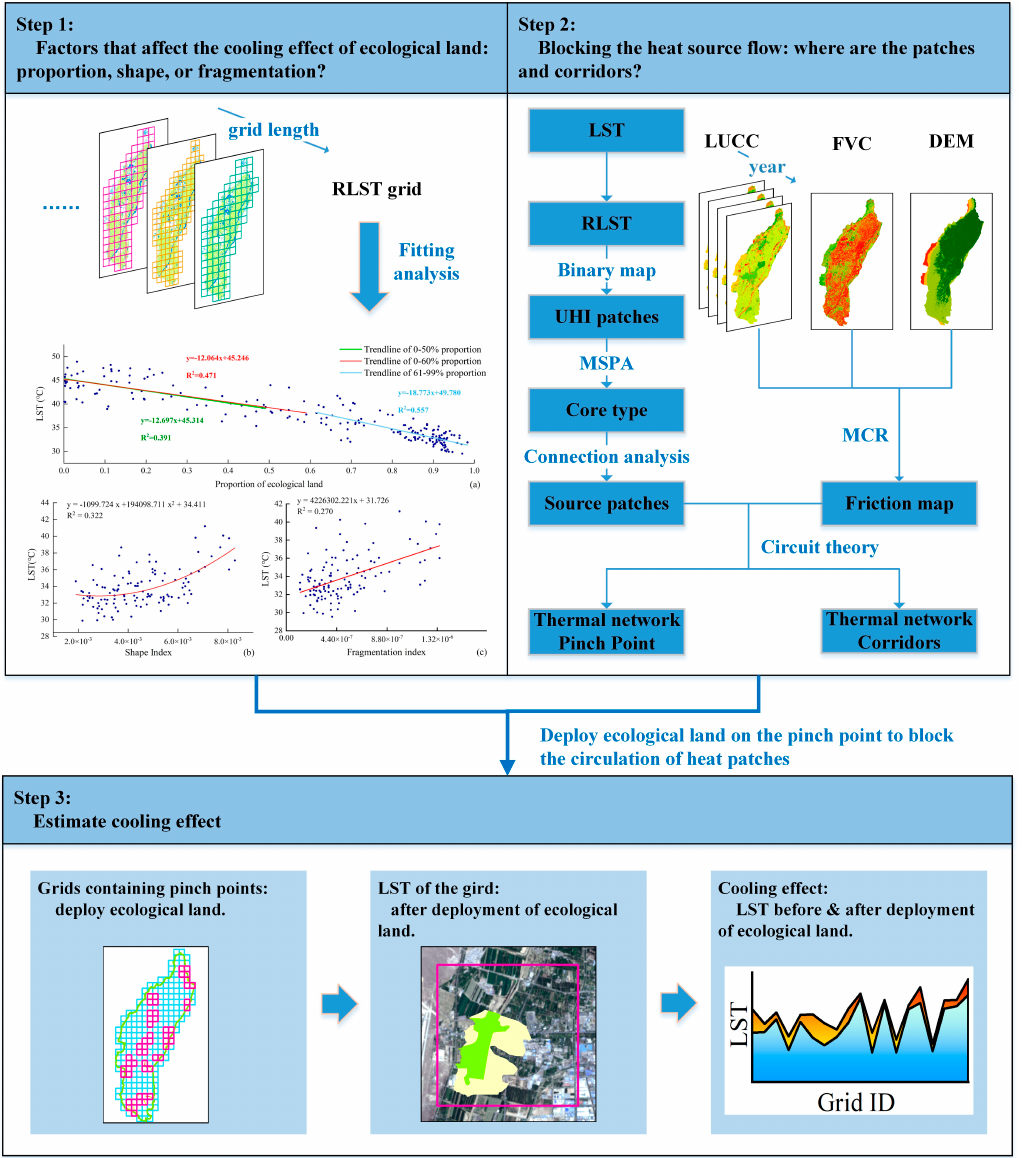
Figure 1. A comprehensive perspective analysis process of the patch and network for cooling surface thermal environment. There are three steps, which are as follows: (1) investigate the effects of landscape composition and spatial configuration on the surface thermal environment; (2) identify the network pinch points and corridors that prevent surface thermal environment circulation; and (3) deploy ecological land at the pinch points to block the connection between the heat patches and cool the surface